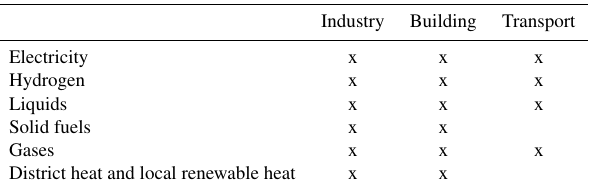
Table 2. Secondary energy carriers included in REMIND and the sectors they are used in. Industry Building Transport Electricity x x x Hydrogen x